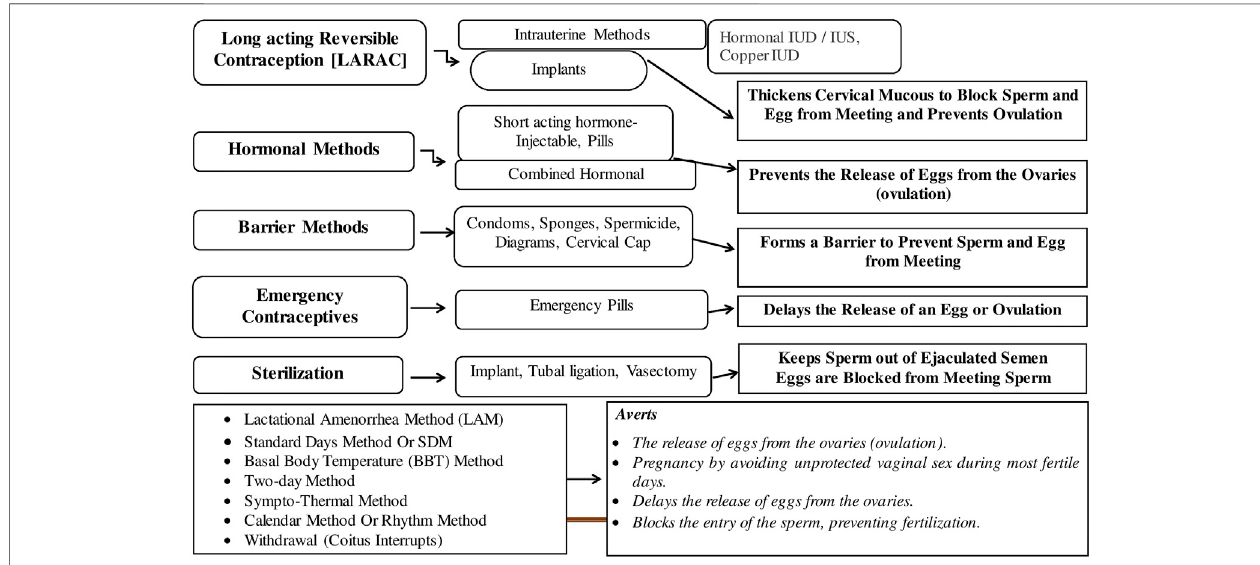
FIGURE 1 | Modern methods of birth